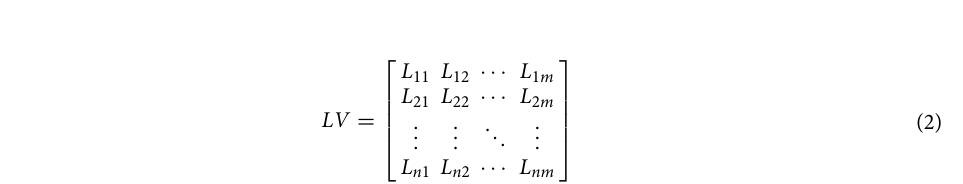
Figure 4. Surface-point as parameter